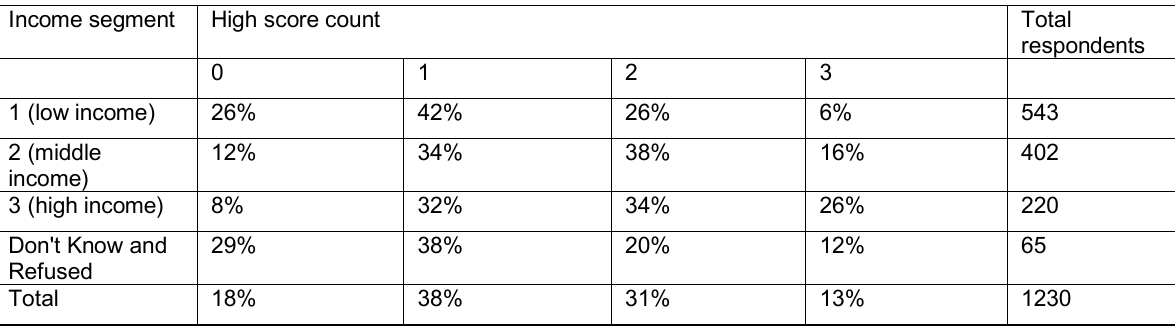
Table 7: Financial Literacy Segments by Income